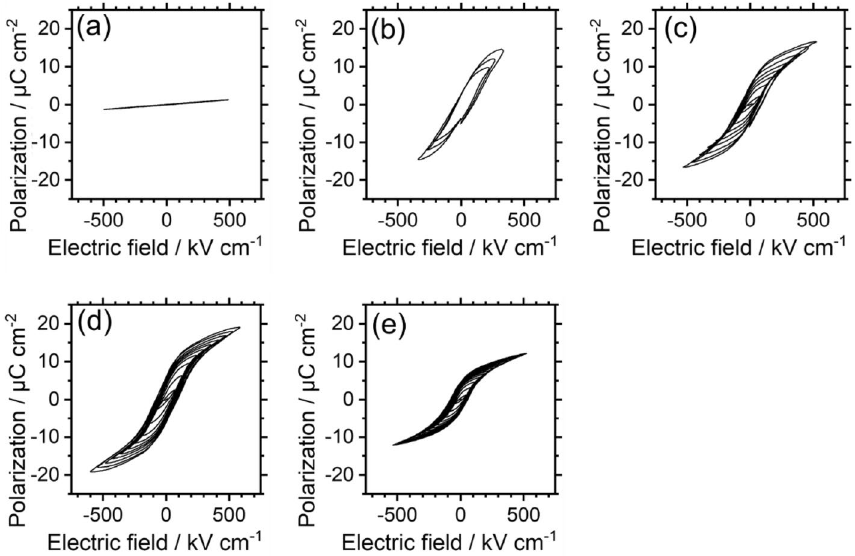
Figure 6. Polarization–Electric field loops for BSO/(101)Nb:TiO 2 with various film thicknesses: ( a ) 100 nm, ( b ) 220 nm, ( c ) 300 nm, ( d ) 430 nm, and ( e ) 670